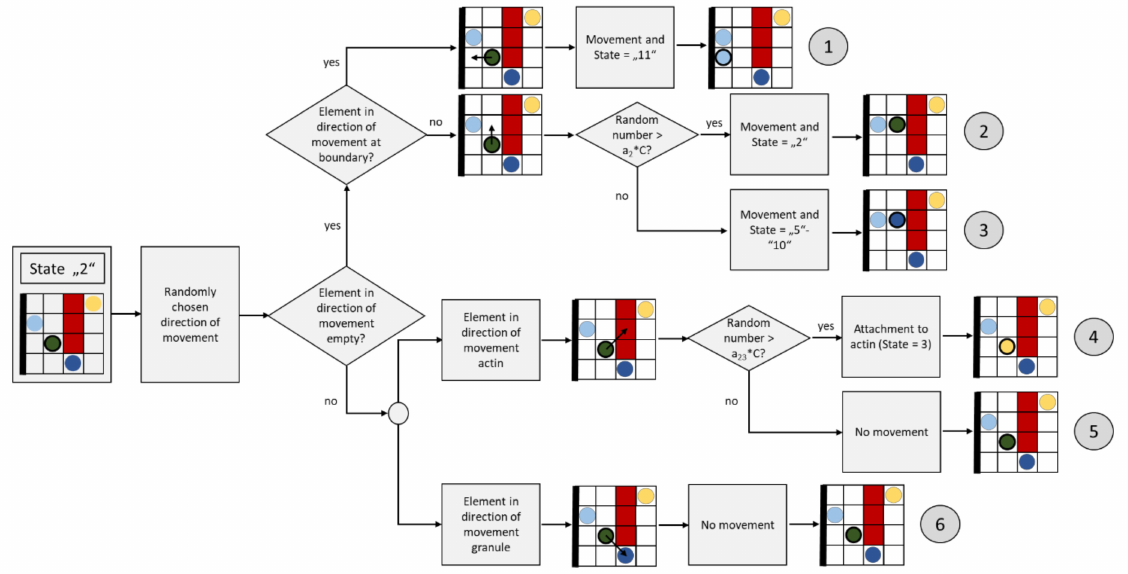
Figure 10. Flowchart for the update rule of a di ff usely moving granule (state